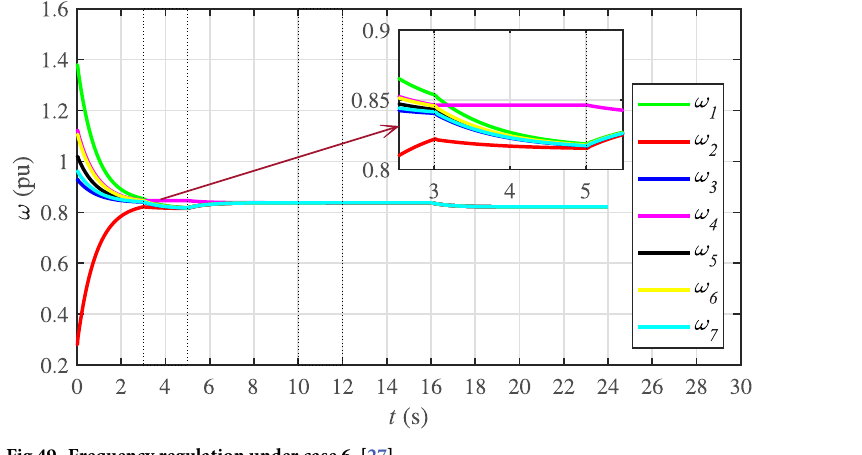
Fig 49. Frequency regulation under case 6. [27].